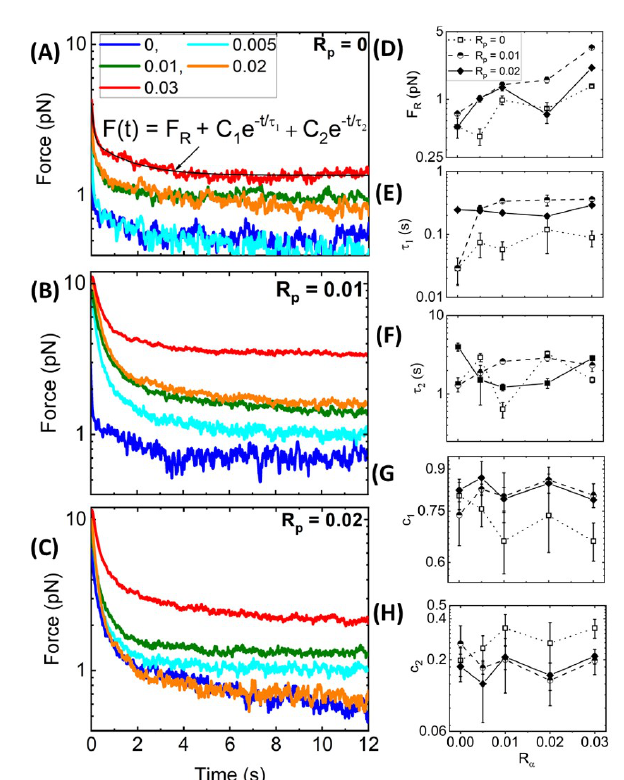
Figure 5. Strain-induced force exponentially relaxes over time to a residual value F r dependent on R p and R α . ( A – C ) Time-dependent relaxation of force F ( t ) following strain for actin networks with varying R α values, color-coded according to the legend, and with R p values of ( A ) 0, ( B ) 0.01, and ( C ) 0.02. All F ( t ) curves are well-described by a sum of two exponential decays with a long- time residual F R : F ( t ) = F R + C 1 exp ( − t / τ 1 ) + C 2 exp ( − t / τ 2 ) as indicated by the representative fit (solid black line) shown in ( A ). ( D – H ) The residual force F R ( D ), decay times τ 1 ( E ) and τ 2 ( F ), and corresponding fractional coefficients, c 1 = C 1 / ( C 1 + C 2 ) ( G ) and c 2 = C 2 / ( C 1 + C 2 ) ( H ), are determined from the fits and plotted as functions of R α for R p = 0 (open squares, dotted connecting lines), R p = 0.01 (half-filled circles, dashed connecting lines), and R p = 0.02 (solid diamonds, solid connecting lines). Error bars shown in ( D – H ) represent the standard error of values computed from 5 random subsets of the data as described in Materials and